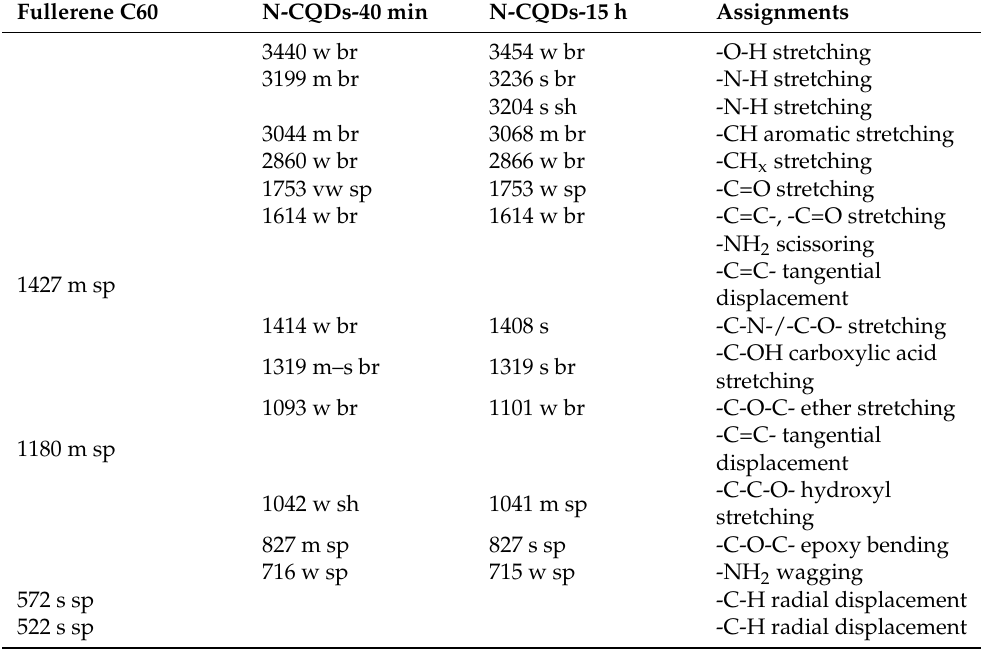
Table 1. Main IR peaks of the pristine fullerene C60, N-CQDs-40 min, and N-CQDs-15 h, as well as the corresponding assignments; s = strong, m = medium, w = weak, vw = very weak, br = broad, sp = sharp, sh =